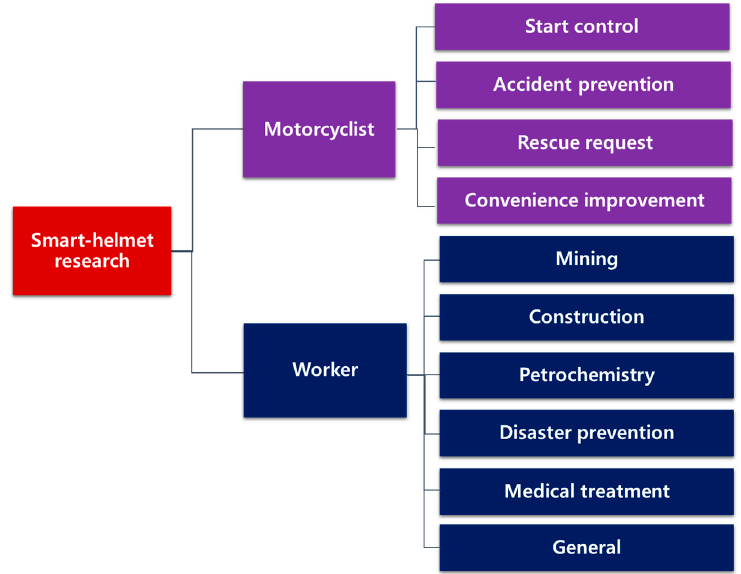
Figure 3. Classification of application fields in smart helmet studies.